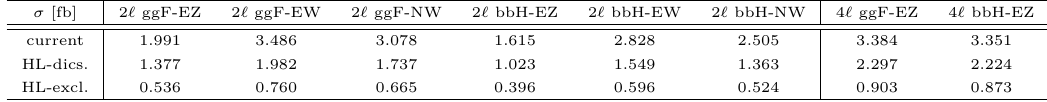
Table 5 . Upper bounds on cross section pp → Φ → ‘ 2 ‘ 4 ( → ‘ 2 V ) [fb]. ( m Φ , m e